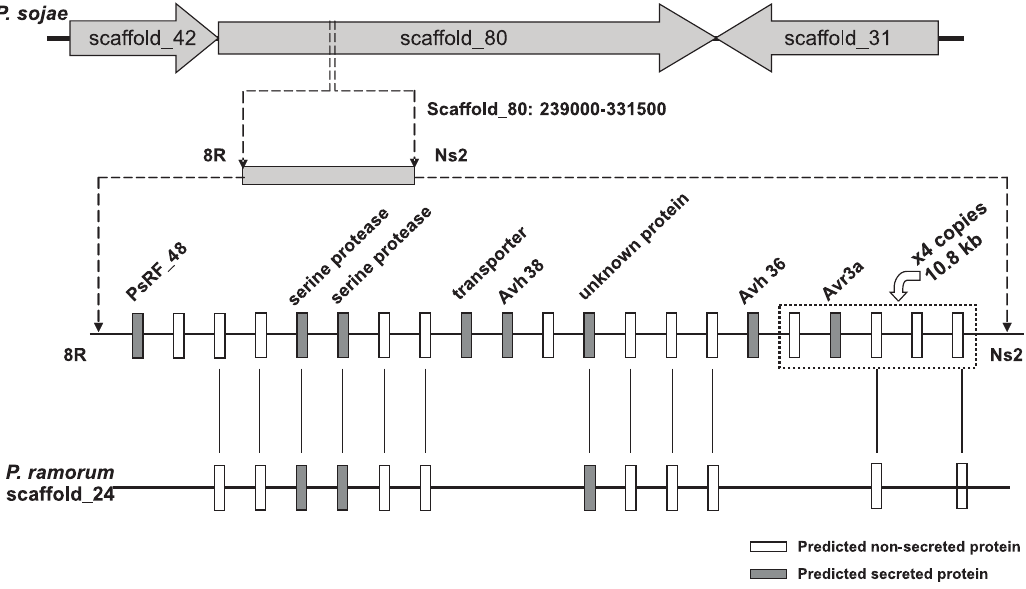
Figure 1. Physical map of the P.sojaeAvr3a and Avr5 region. Shown are the positions of predicted genes including candidate RXLR effector genes, and synteny with P. ramorum . In P. sojae strain P6497, Avr3a is embedded in a 10.8 kb DNA segment that is present in a tandem array of four copies, which is shown as a box in this illustration (not drawn to scale). Scaffold designations are from v1.0 of the genome sequence.